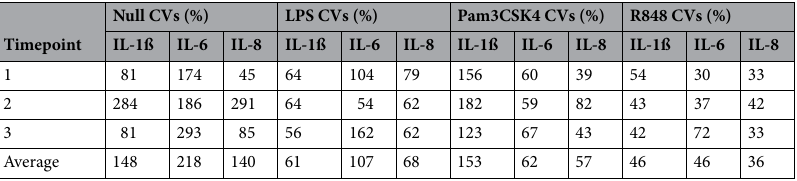
Table 1. The inter-individual variation in null and induced responses represented by CVs calculated between individuals.